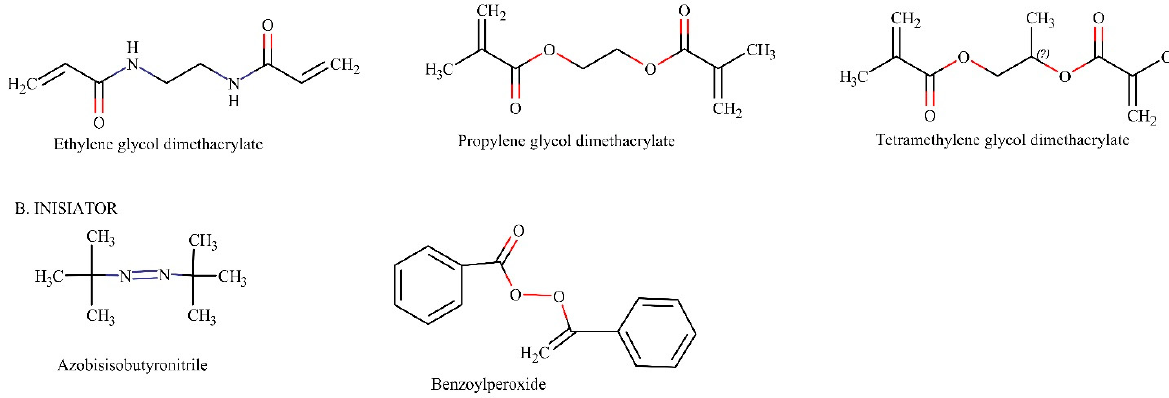
Figure 3. Crosslinkers and Inisiator .